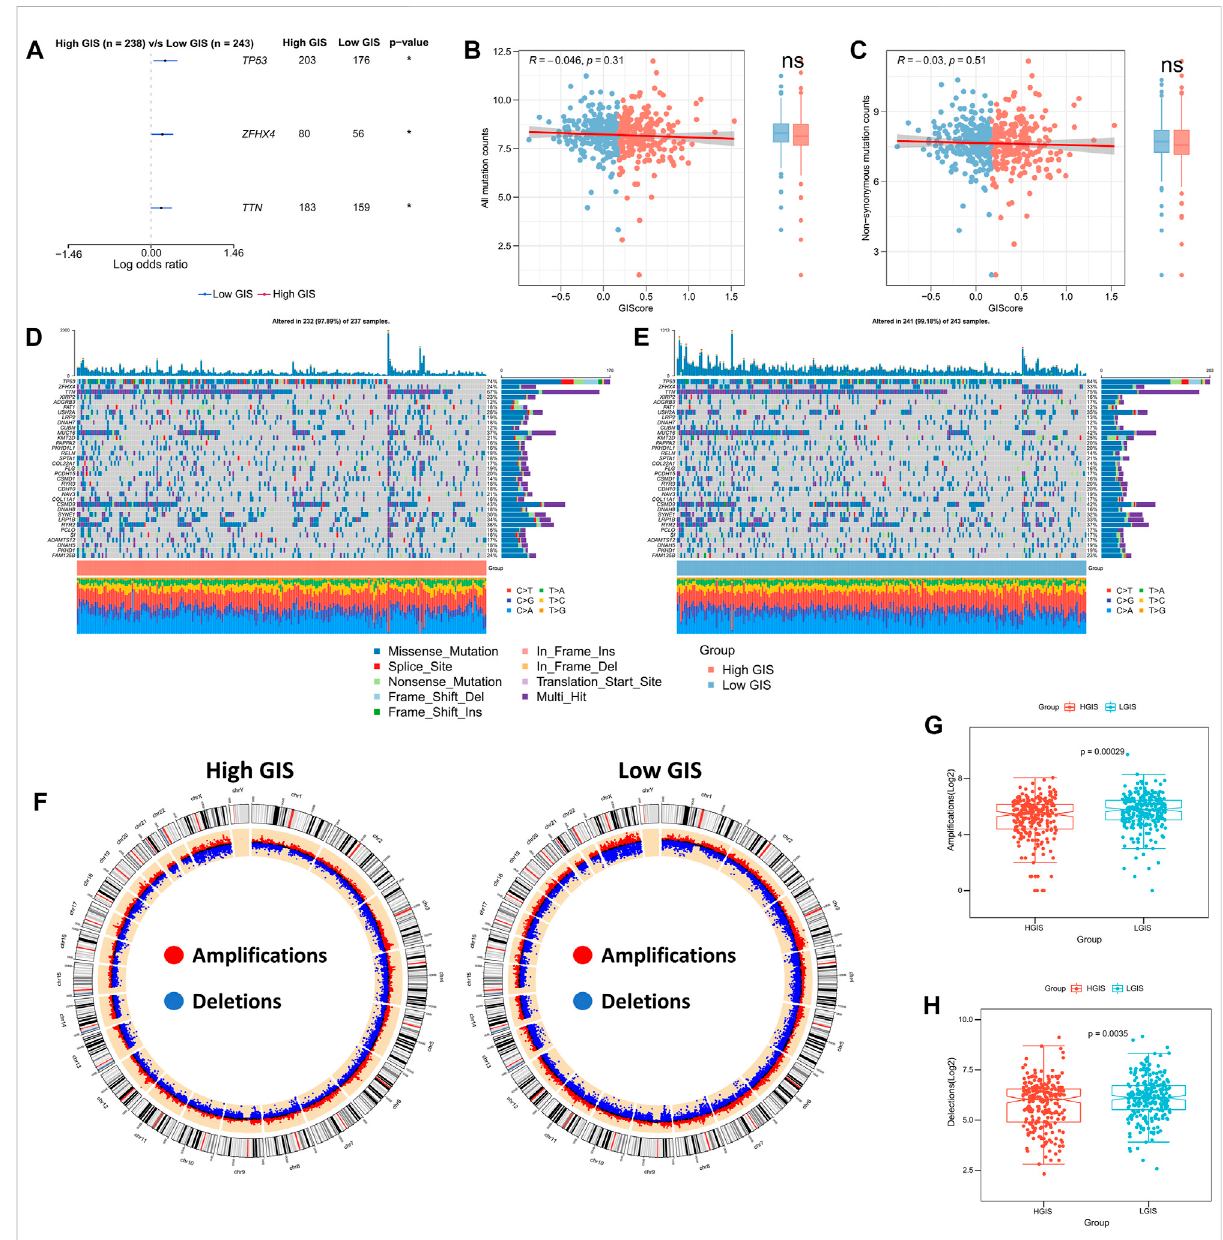
FIGURE 6 Genomic mutation landscapes of GIS models. (A) Forest map of the high-frequency mutated genes with signi fi cant mutation differences between the high GIS and low GIS groups. (B) Correlation between GIS and all mutant loads. (C) Correlation between GIS and non-synonymous mutation load. (D) Oncoplot of the high-frequency mutated genes in the high GIS group. (E) Oncoplot of the high-frequency mutated genes in the low GIS group. (F) Circle diagram summarizing CNV events on different chromosome arms in the high and low GIS groups. (G) Box plot of the differenceinchromosomeampli fi cationbetweenthehighGISandlowGISgroups. (H) Boxplotofthedifferenceinchromosomedeletionsbetween the high GIS group and the low GIS group. GIS, glycolysis – immune score; CNV, copy number